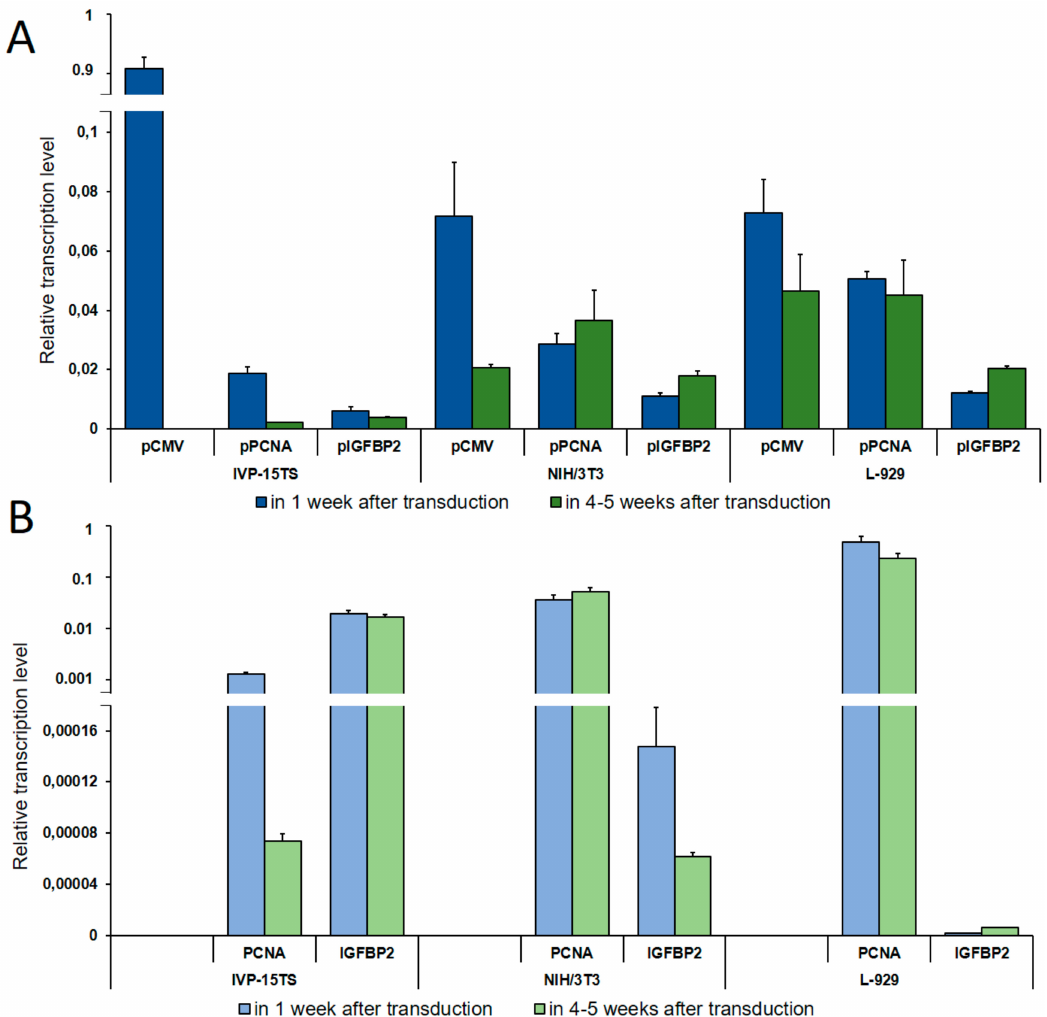
Figure 2. Determination of Relative Transcription Level. ( A ) Relative transcription level of the transgene under the control of pCMV, pPCNA, and pIGFBP2 promoters as determined by qPCR analysis. ( B ) Relative transcription level of the PCNA and the IGFBP2 genes. The names of promoters or genes are indicated below the abscissa axis. The measurements were performed in three independent replicate experiments for each sample and are represented as mean ±